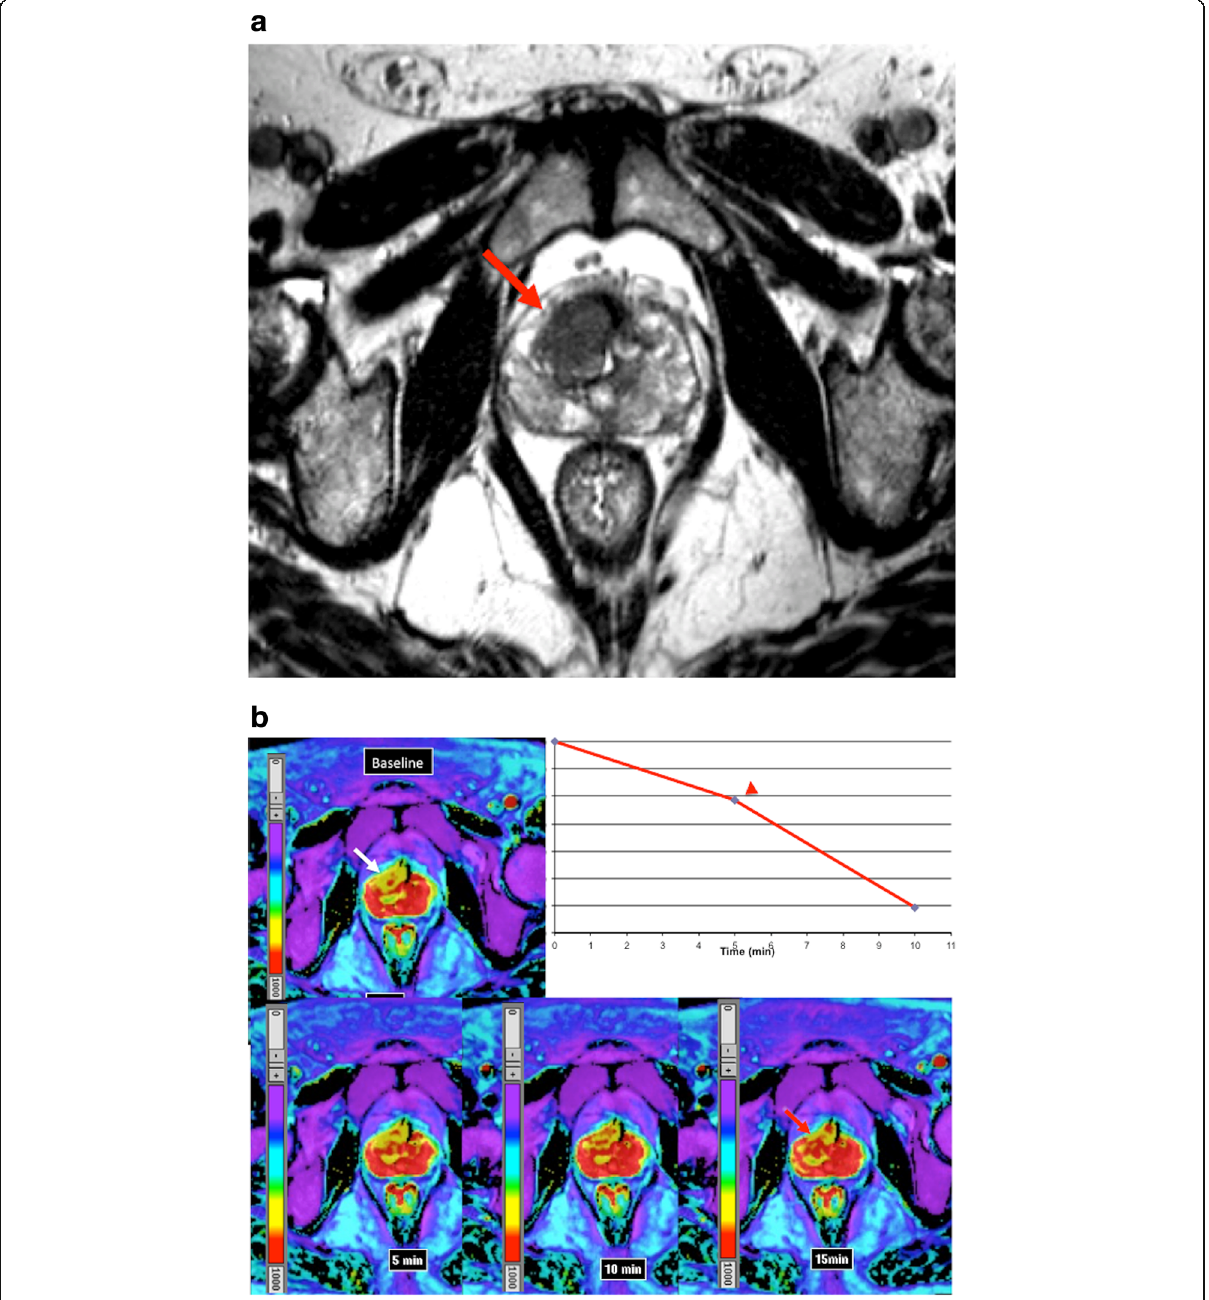
Fig. 10 BOLD sequence and tumor oxygenation. a Axial T2-weighted image in a 63-year-old man evidenced a poor defined hypointense mass in the anterior part of the transitional gland corresponding to prostate cancer (white arrow). b BOLD exam acquired in the axial plane at baseline and after evidenced that in baseline conditions the tumor (white arrow) showed low signal in the T2* map (high R2* values), which is related to a lower oxygenation compared to the rest of the prostate. BOLD images after 95% oxygen breathing at 5, 10, and 15 m evidenced that the signal increased witihin the tumor (red arrow in the acquisition at 15 min) with an inverted Δ R2* time-intensity curve (red arrowhead). These features evidence the presence of radiosensitive areas within the tumor with increasing pass of oxygen from blood to the tissue. The concentration of deoxyHb increases with rising oxygen consumption, leading to a decreasing T2* relaxation time of the surrounding